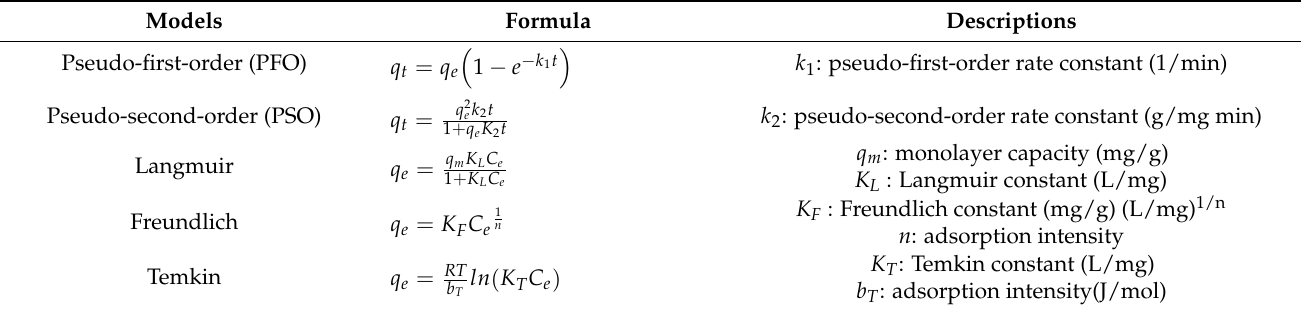
Table 5. Adsorption kinetics and isotherms nonlinear